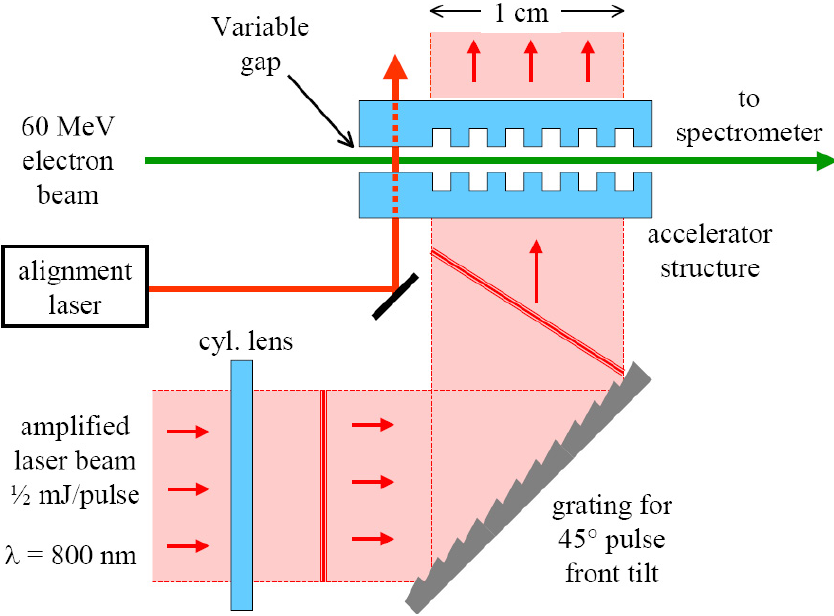
FIG. 9. (Color) The proposed setup for beam experiments with the double-grating structure.